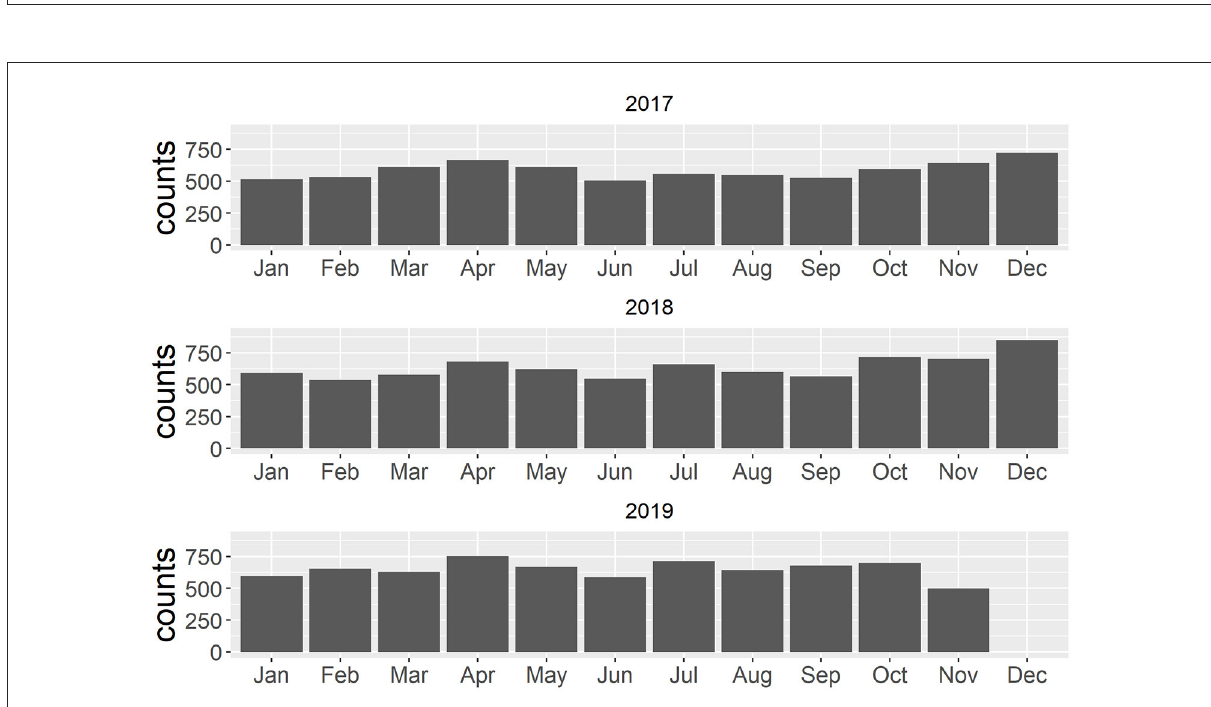
FIGURE4 Number of live pig movements within North Macedonia by shipment month for